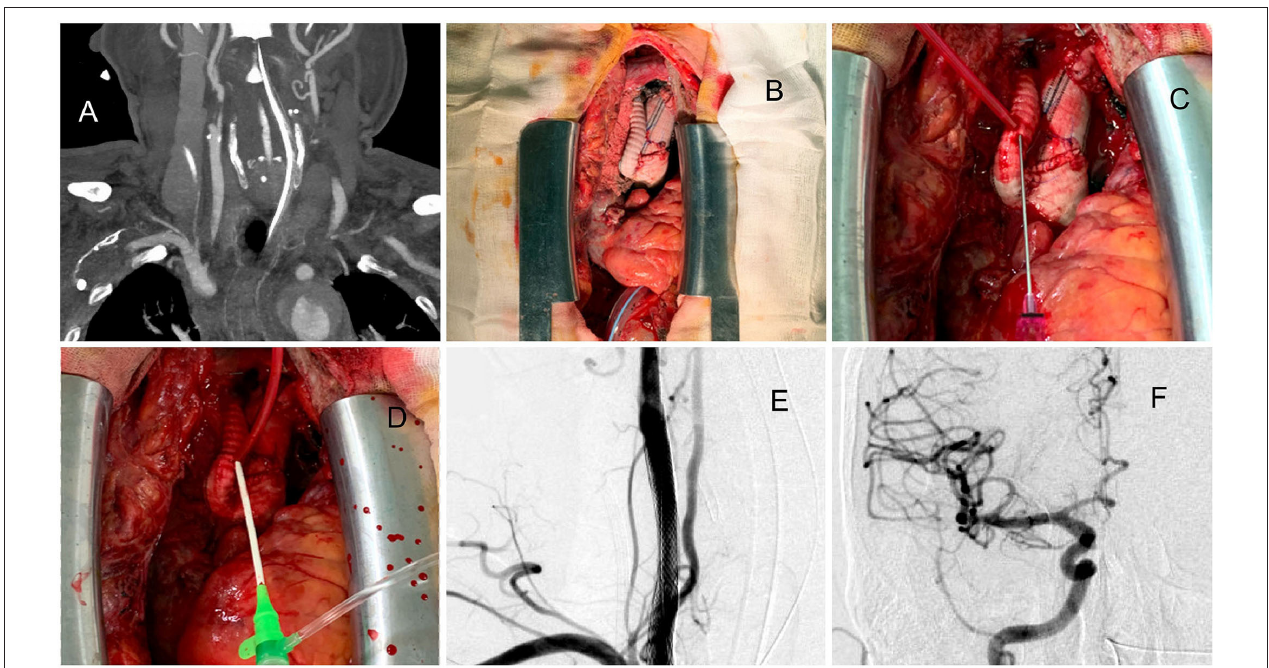
FIGURE 3 | A case approached from exposure to the artificial aortic graft after type A aortic dissection surgery. (A) Dissecting extended to the right CCA and proximal ICA. (B) After open cardiac surgery, the reimplanted graft was exposed. (C) Direct puncture of the artificial graft. (D) The puncture needle was replaced with a 6-Fr sheath. (E) Two carotid stents were deployed to cover the proximal ICA to proximal CCA. (F) Thrombolysis in cerebral infarction (TICI) 3 results of the procedure.